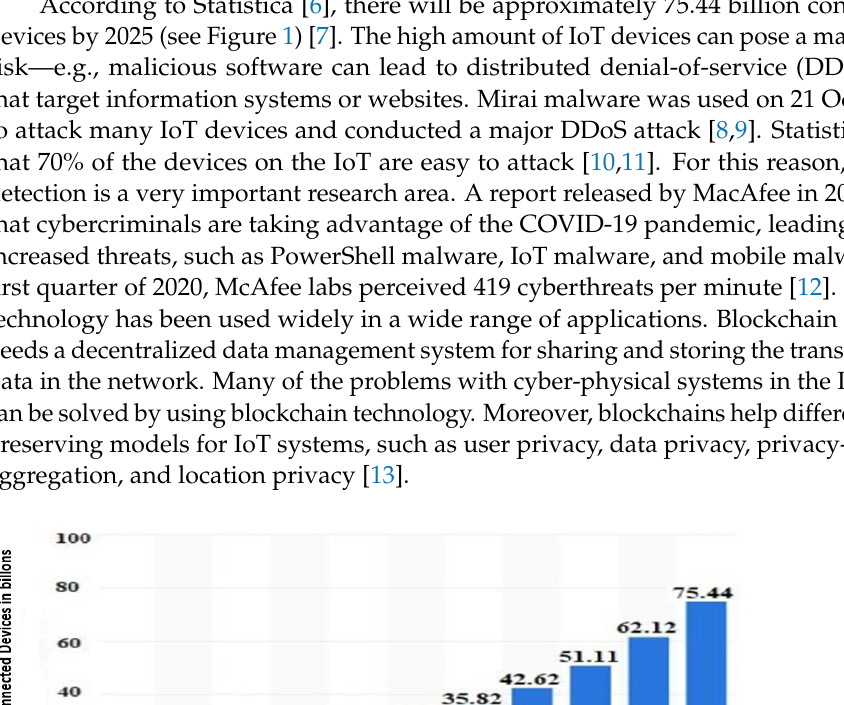
Table 1. Population, Intervention, Comparison, Outcomes, and Context (PICOC) criteria. Population Intervention Comparison